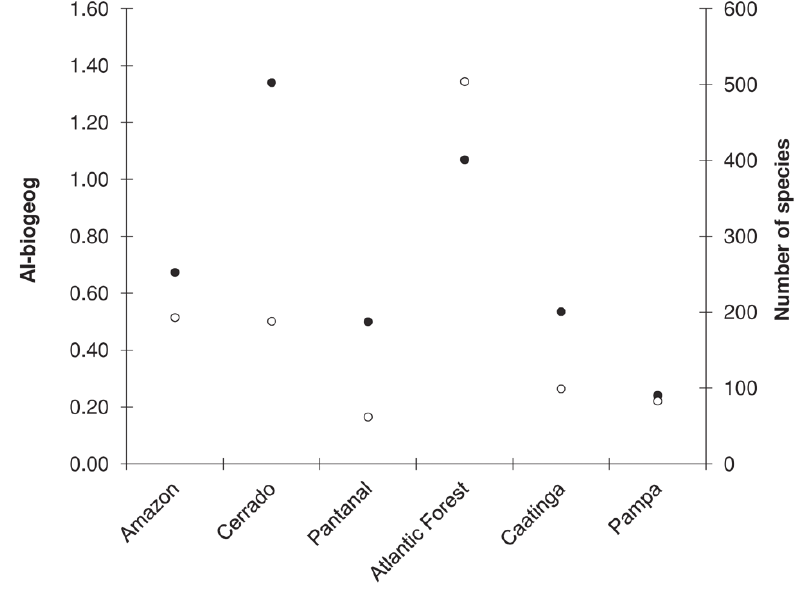
Figure 1 - Biogeographic attention index (black dots) and total number of amphibian species recorded (white dots) for each biome in Brazil.